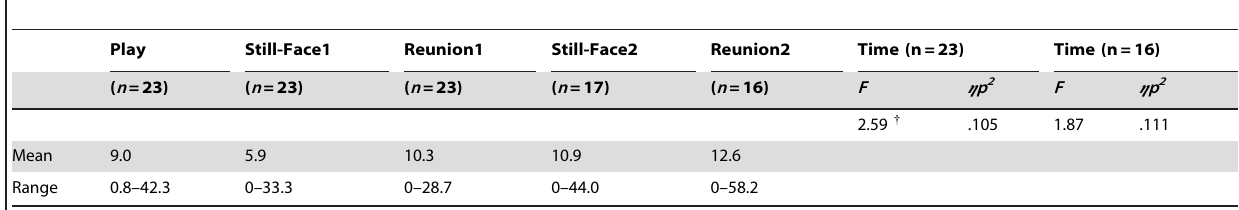
Table 1. Percentages of breaths too short to allow extraction of two inter-beat intervals for peak-valley RSA calculation in